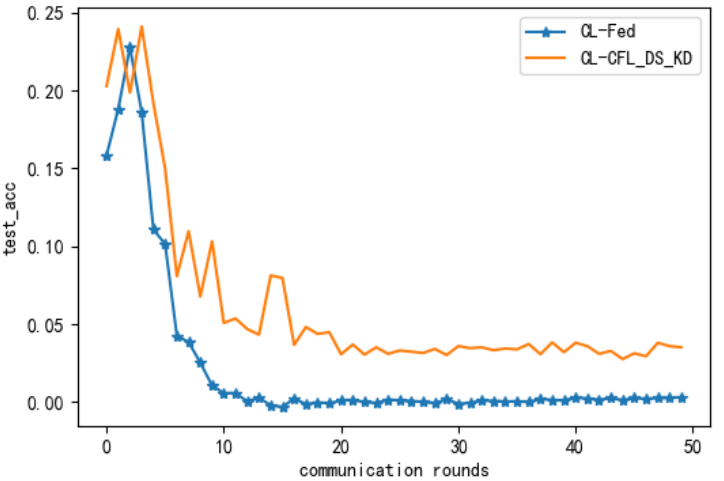
Figure 11. The difference between the CFL_DS_KD and CL method